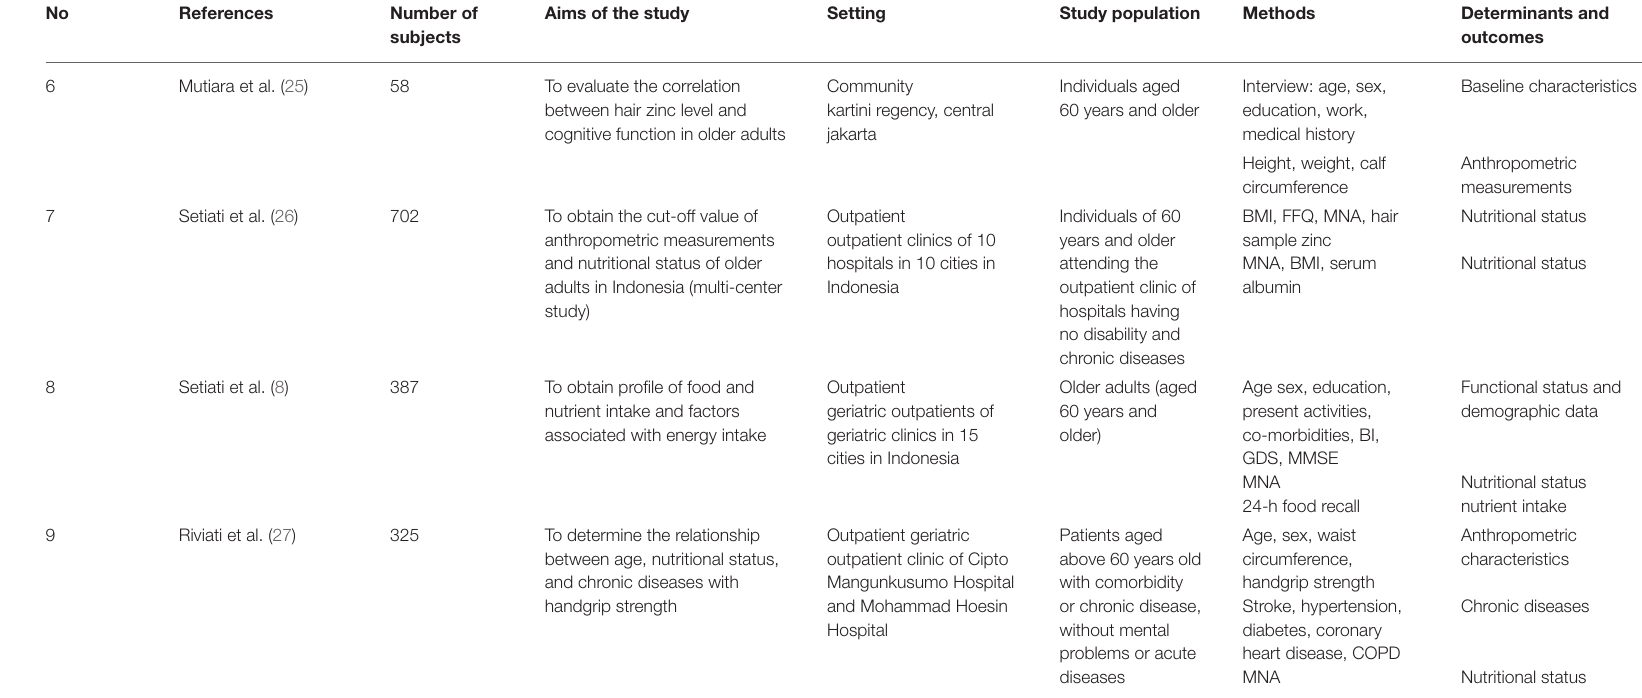
BI, Barthel Index; MNA, Mini Nutritional Assessment; FTU, Functional Tooth Units; BMI, Body Mass Index; CRP, C-Reactive Protein; ELISA, Enzyme-Linked Immuno-Sorbent Assay; FFQ, Food Frequency Questionnaire; IL, Interleukin; IFN, Interferon; PTH, Parathyroid Hormone; MMSE, Mini-Mental State Examination; GDS, Geriatric Depression Scale; COPD, Chronic Obstructive Pulmonary